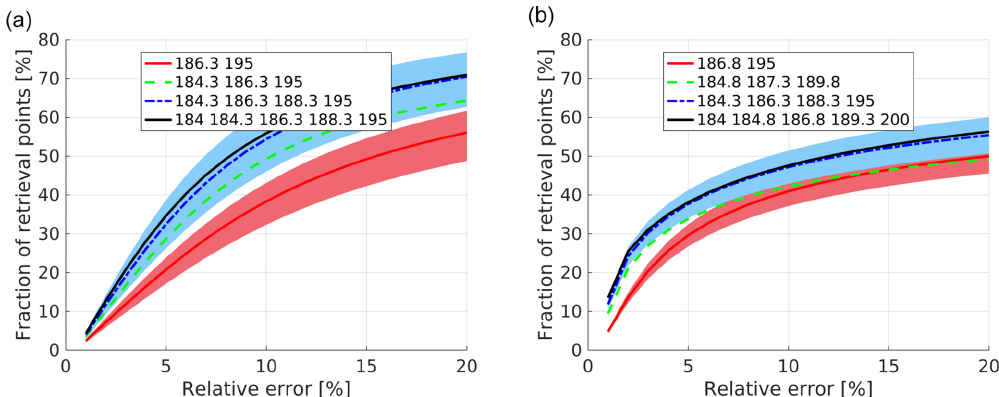
Figure 8. Fraction of retrieval points ( y axis) having errors lower than a given threshold ( x axis) for the space-borne configuration (a) and the ground-based configuration (b) with 2, 3, 4 and 5 tones. Only the combinations that achieve the best accuracies (as indicated in the legend) are reported. The shaded region indicates results when the sensitivity is increased or decreased by 3dB. For the space-borne (ground-based) configuration the retrieval is applied only to points corresponding to CloudSat reflectivities exceeding − 15dBZ ( − 25dBZ) and temperature exceeding